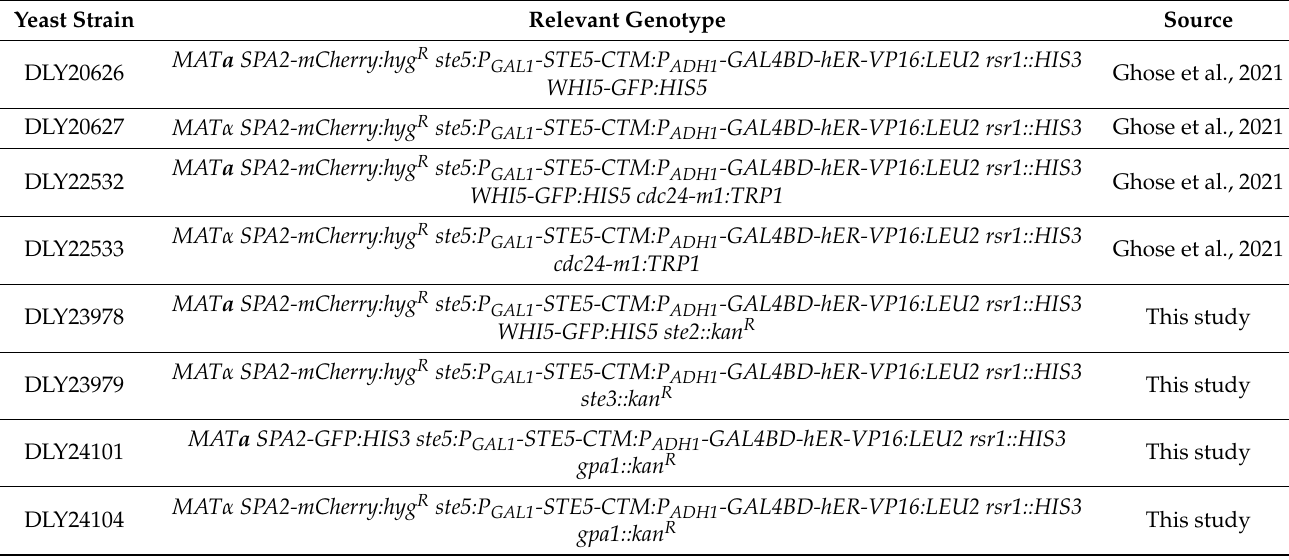
Table 1. Yeast strains and